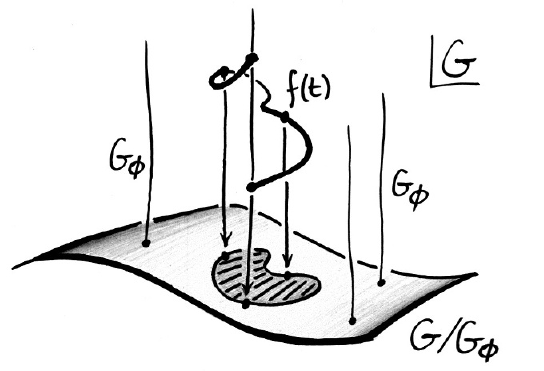
Figure 1 . A path f ( t ) in G such that f ( T ) = f (0) (cid:1) h with h 2 G (cid:30) is mapped on a closed curve in G=G (cid:30) by the projection (cid:25) : G ! G=G (cid:30) : f 7! f (cid:1) G (cid:30) . When G=G (cid:30) is a coadjoint orbit, the Berry phase along f ( t ) coincides with the (cid:13)ux of the Kirillov-Kostant symplectic form through any surface enclosed by the projected path on G=G (cid:30) . For f ( t ) = f (0) (cid:1) h ( t ) with h ( t ) 2 G (cid:30) , the projected path is a point and the Berry phase